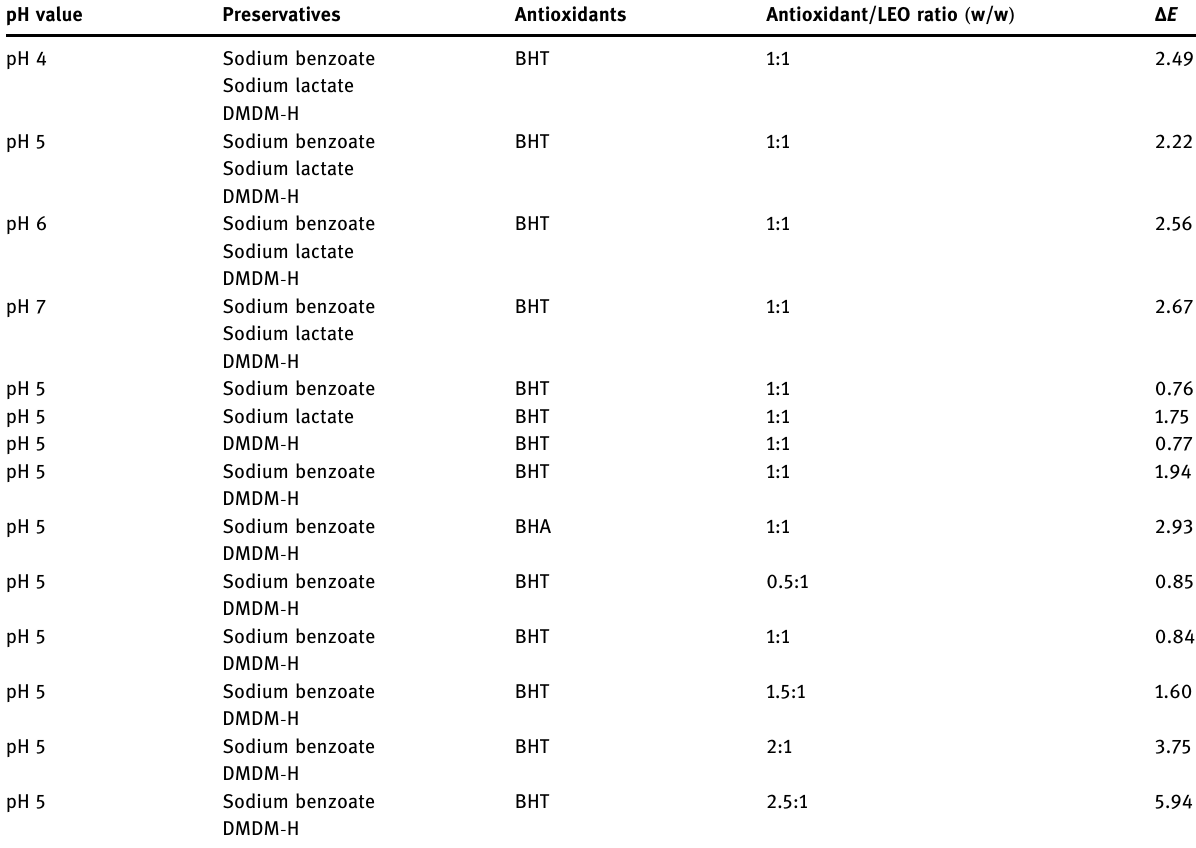
Table 4: Color change of the washing product base after 7 days of storage at 45°C formulated at di ff erent process conditions pH